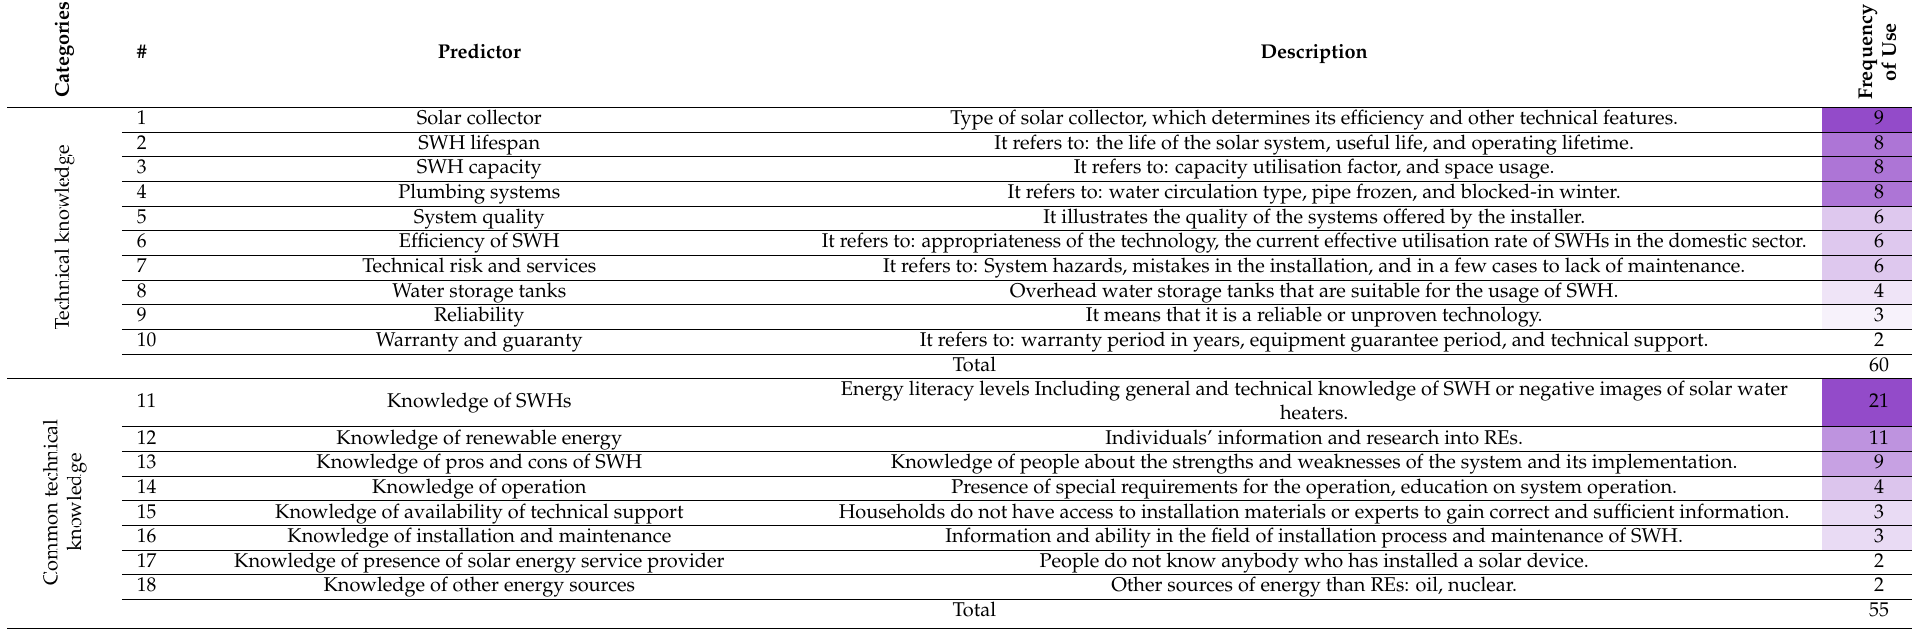
Table A2. Technical characteristics of household adoption of solar systems. The purple colour of the numbers in front of each predictor indicates their use frequency. Darker colour = more common in